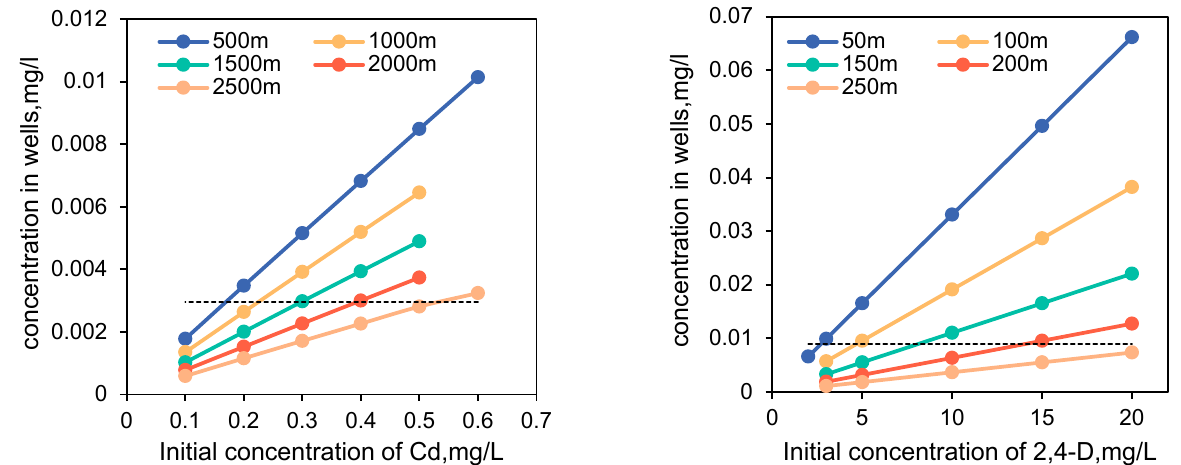
Figure 6. Initial concentration of leachate required to be controlled for various pollutants at different distances between a sensitive water source and a landfill.